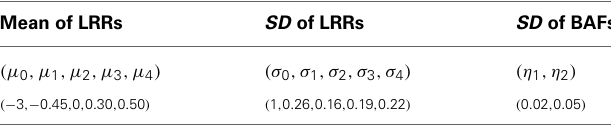
Table 2 | Parameters characterizing the distribution of LRRs and BAFs. Mean of LRRs SD of LRRs SD of